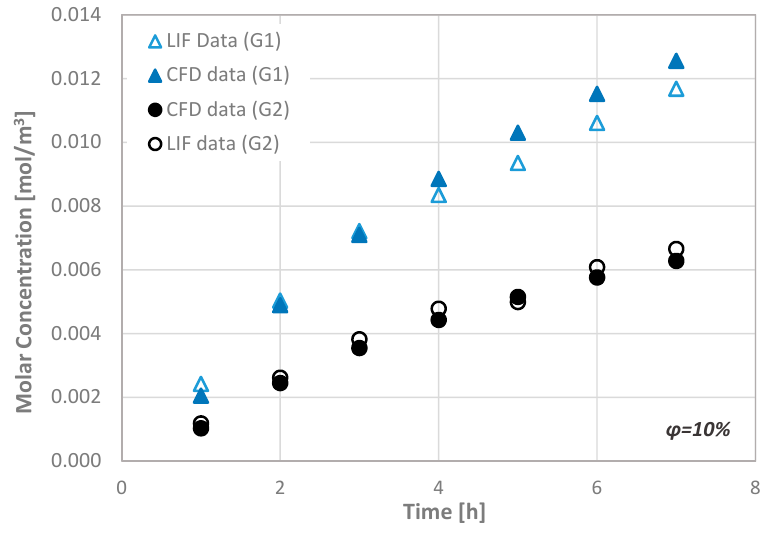
Figure 4. Typical comparison of the molar concentration values at the observation area of the μ -LIF technique with the corresponding computational results ( φ = 10%).